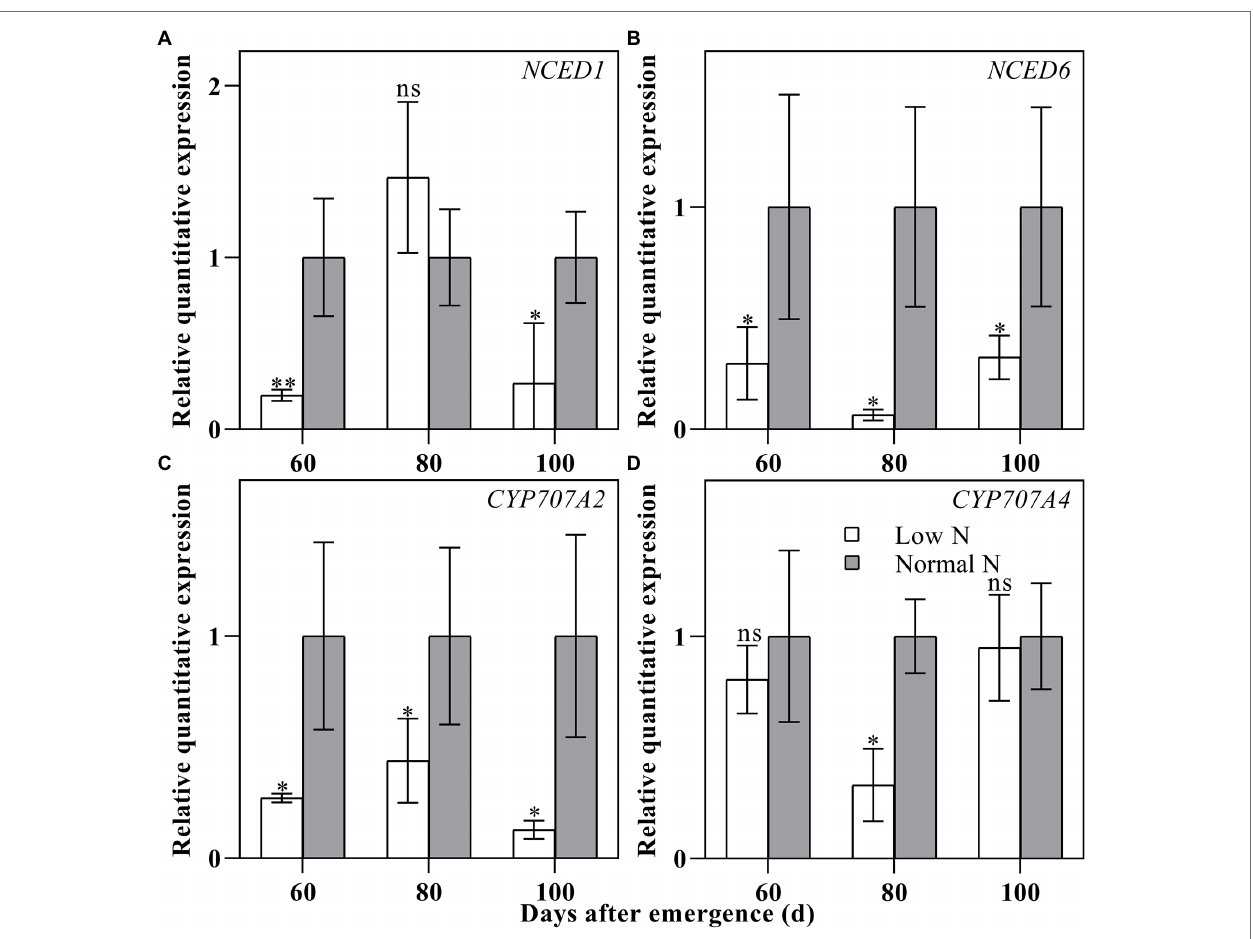
FIGURE 4 | Relative quantitative expressions of NCED1 (A) , NCED6 (B) , CYP707A2 (C) , and CYP707A4 (D) in cotton roots under different nitrogen treatments. Depicted are the means of three replicates ± SE. ns, not significant ( p > 0.05), * p < 0.05, ** p <